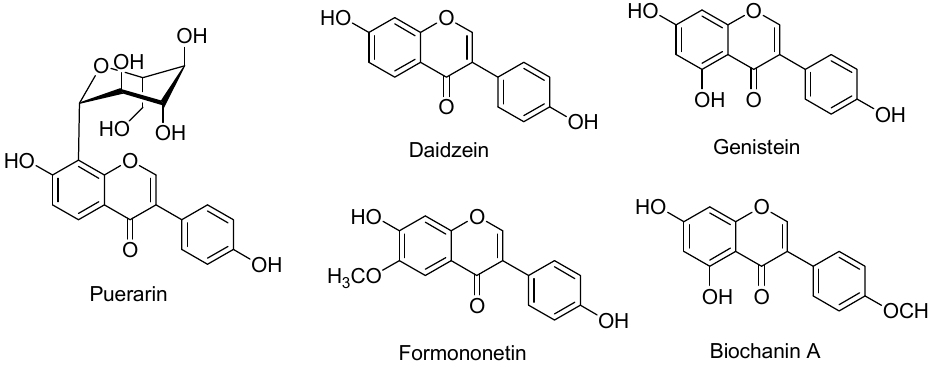
Figure 1. Chemical structures of isoflavones, puerarin, daidzein, genistein, formononetin, and biochanin A.